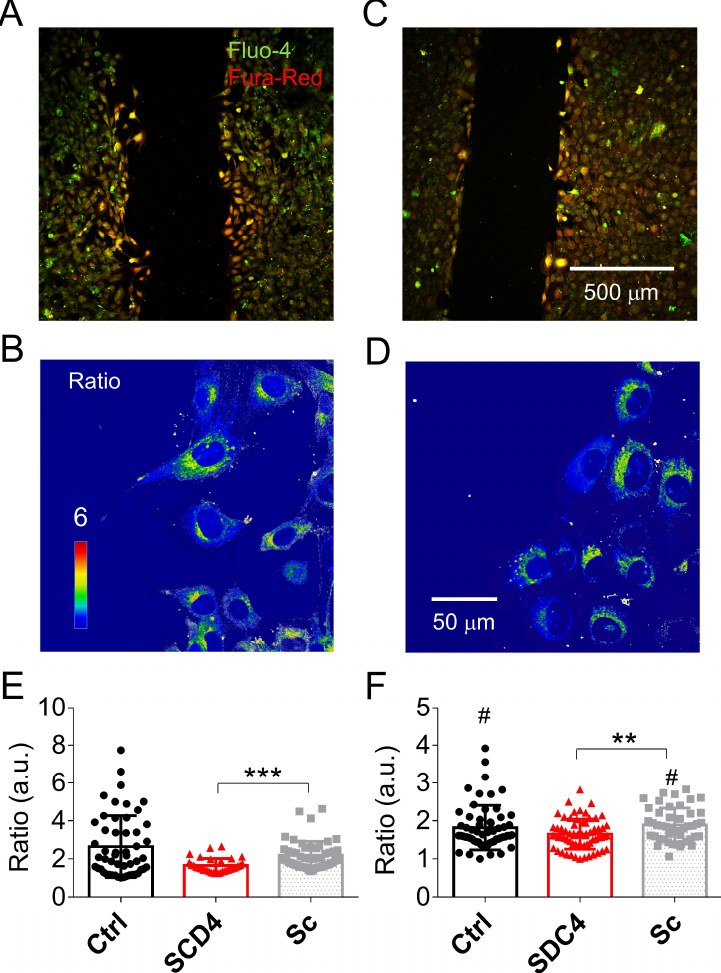
Figure 6. Representative low magnification merged images 4 h after removing the insert from the scrambled ( A ) and Syndecan-4 KD ( C ) cell culture. High magnification ratio image showing migrating scrambled ( B ) and Syndecan-4 KD ( D ) cells. The average fluorescent ratio of the migrating ( E ) and nonmigrating ( F ) control (black), knockdown (red), and scrambled (grey) cells. The number of cells averaged was 52, 33, and 26 in migrating and 61, 65, and 46 in nonmigrating from 3 independent control (Ctrl), Syndecan-4 KD (KD), and scrambled (Sc) cell cultures, respectively. **, and *** denote significant difference from scrambled cell cultures at p < 0.01, and p < 0.001, respectively. # denotes a significant difference from migrating cells from the same group at p <